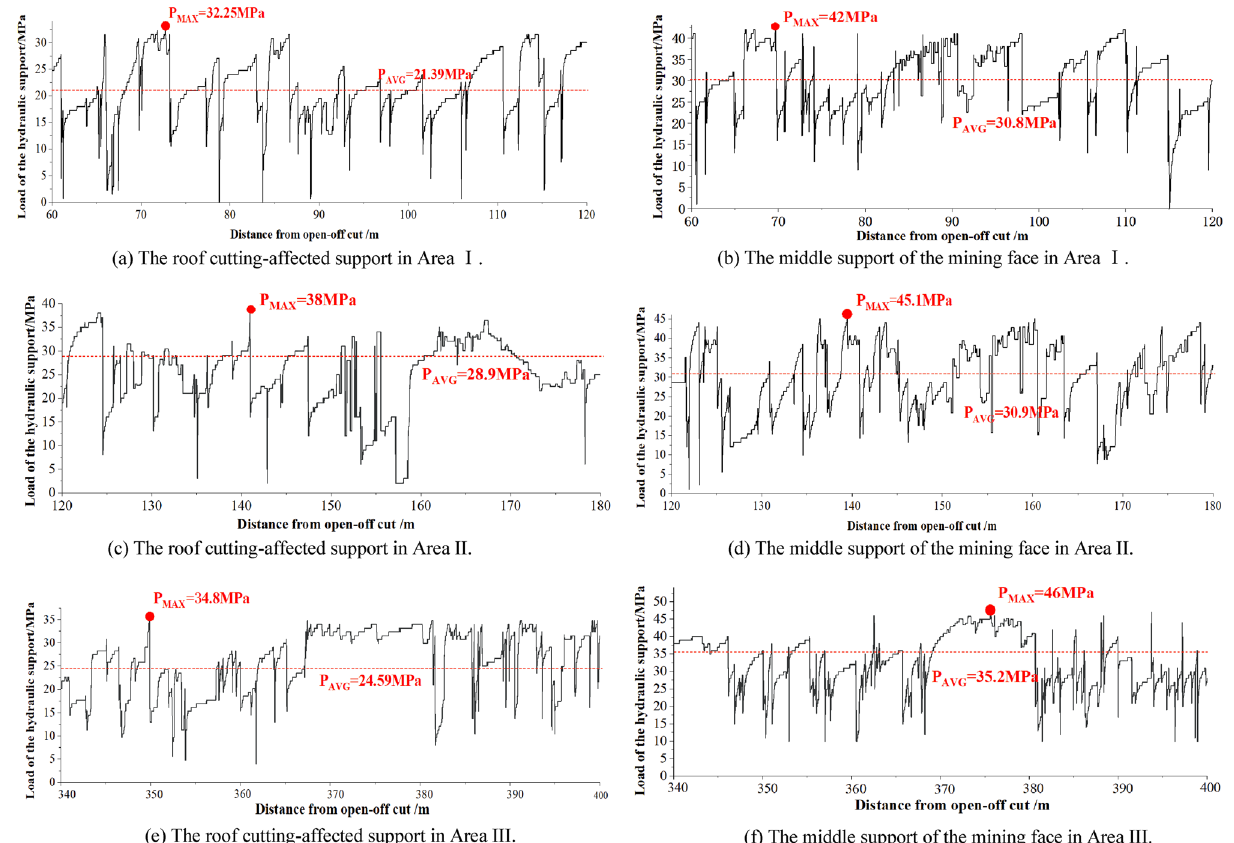
Figure 11. Variation in the roof loads in the active mining face for different test